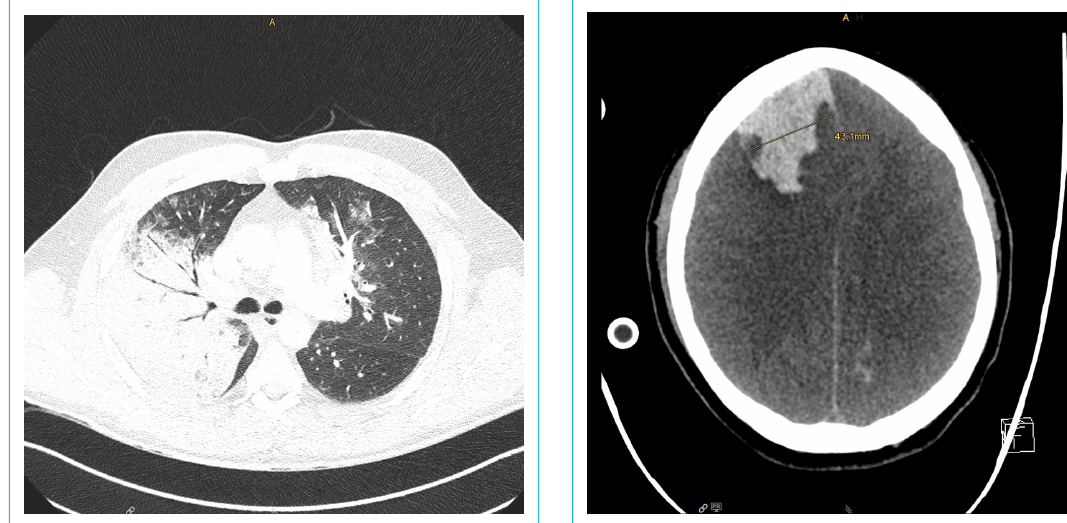
Figure S1: Patient 1: Computed tomography scan of the thorax showing right upper lobe consolidation and bilateral ground glass opacifications (diagnosis: pneumonia due to Chlamydia psittaci ).